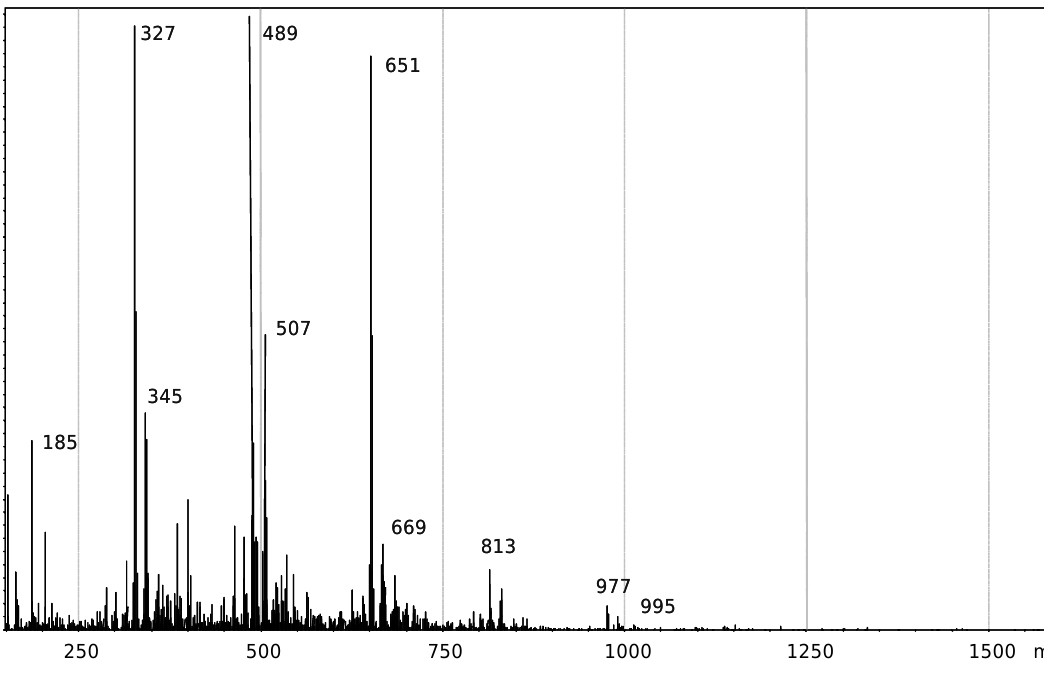
Figure 5. LC-MS spectrum of isoeugenol